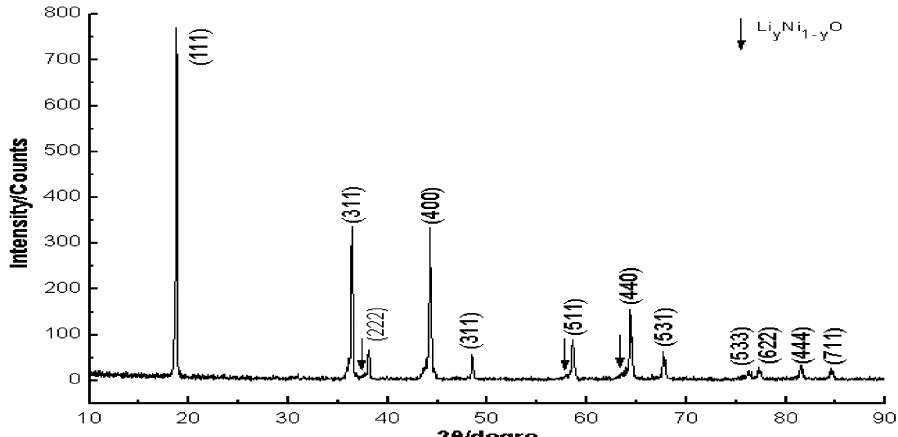
Fig. 4: XRD pattern of LiNi 0.5 Mn 1.5 O 4